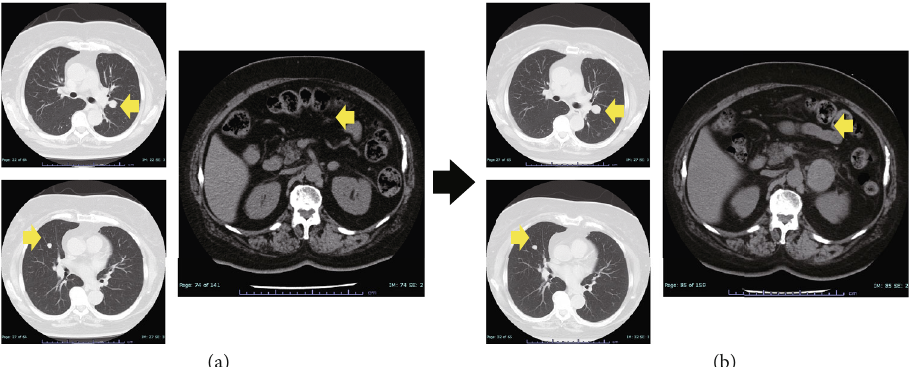
Figure 1: Computed tomography of lung tumors and a left adrenal tumor (arrows). (a) At the time when the left adrenal tumor was initially identi fi ed. (b) Six months after the initial diagnosis of the left adrenal